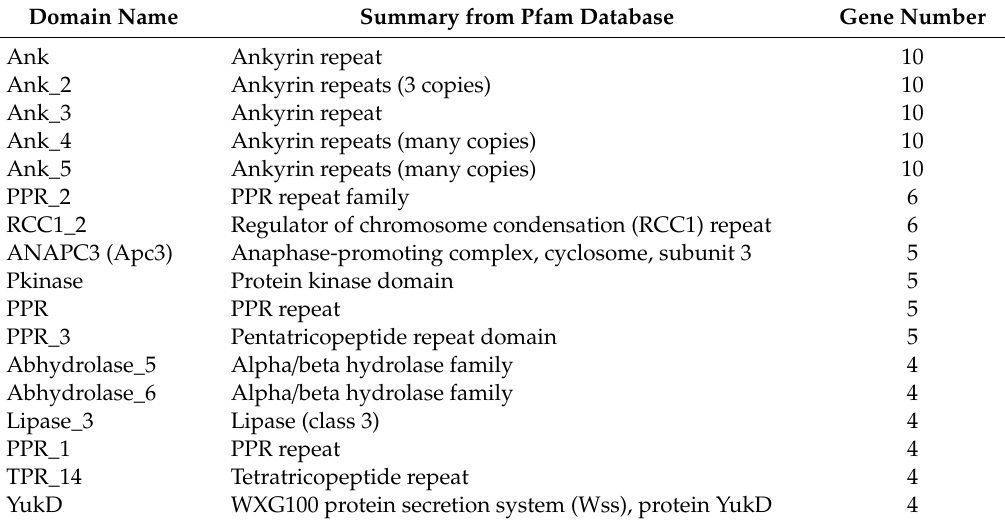
Table 2. Domains encoded by more than three down-regulated genes in Cladocopium